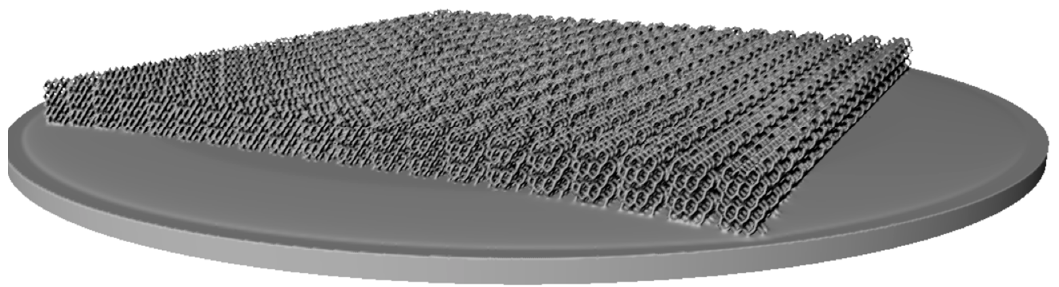
Figure 7. The array of 20 × 20 BI004 models.